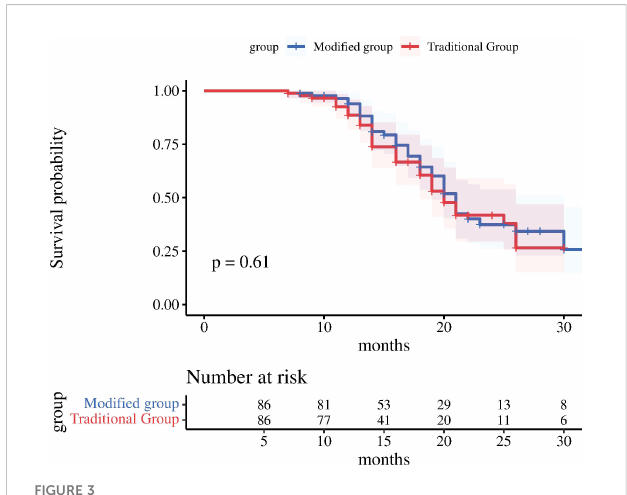
FIGURE 3 OS survival analysis curves for both